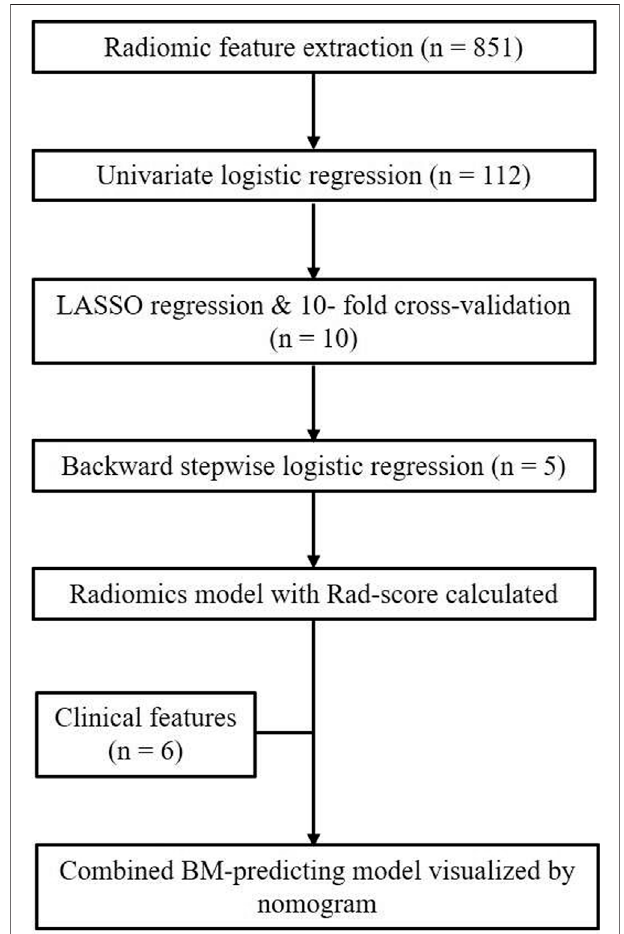
FIGURE 5 | Flowchart of the process involved in the development of the prediction